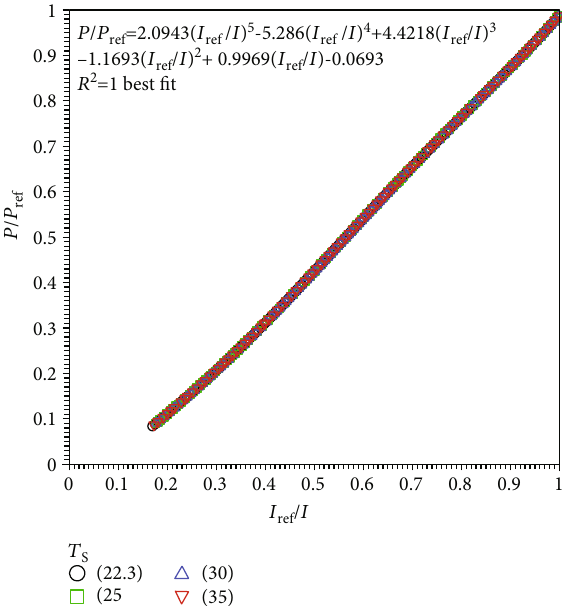
Figure 7: Calibration curve at di ff erent temperatures: 22.3, 25, 30, and 35 °